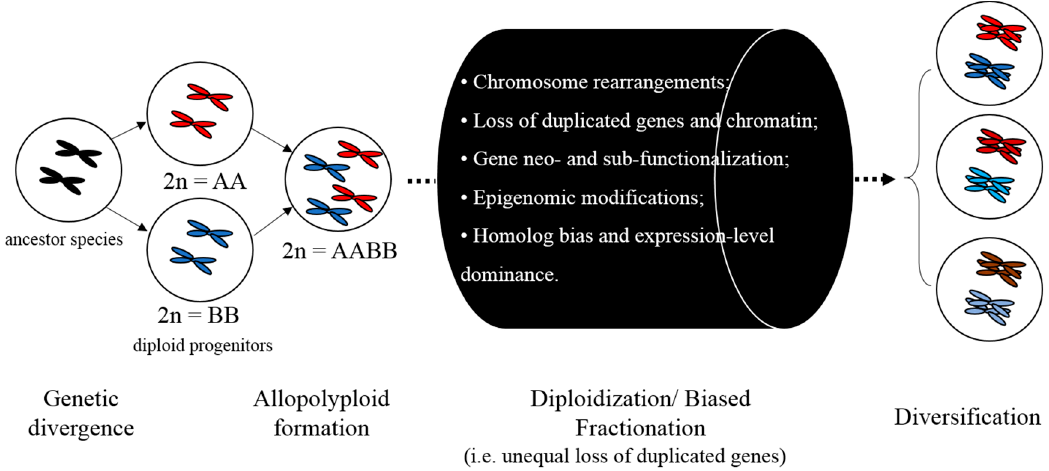
Figure 1. Conceptual illustration of key realizations in plant genome architecture. The merger of two diploids via hybridization and/or allopolyploidy has novel evolutionary consequences [21], enumerated in the black cylinder.